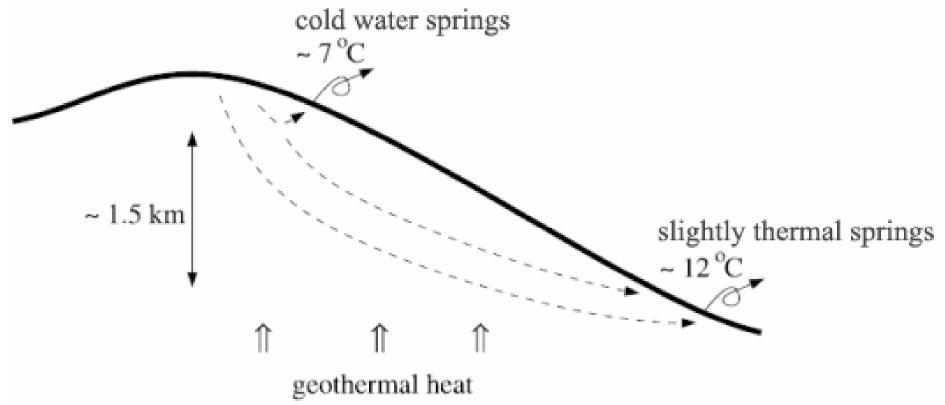
Figure 1. Conceptual diagram indicating flow path differences between shallow coldwater springs and slightly thermal springs from volcanic regions. Adapted from